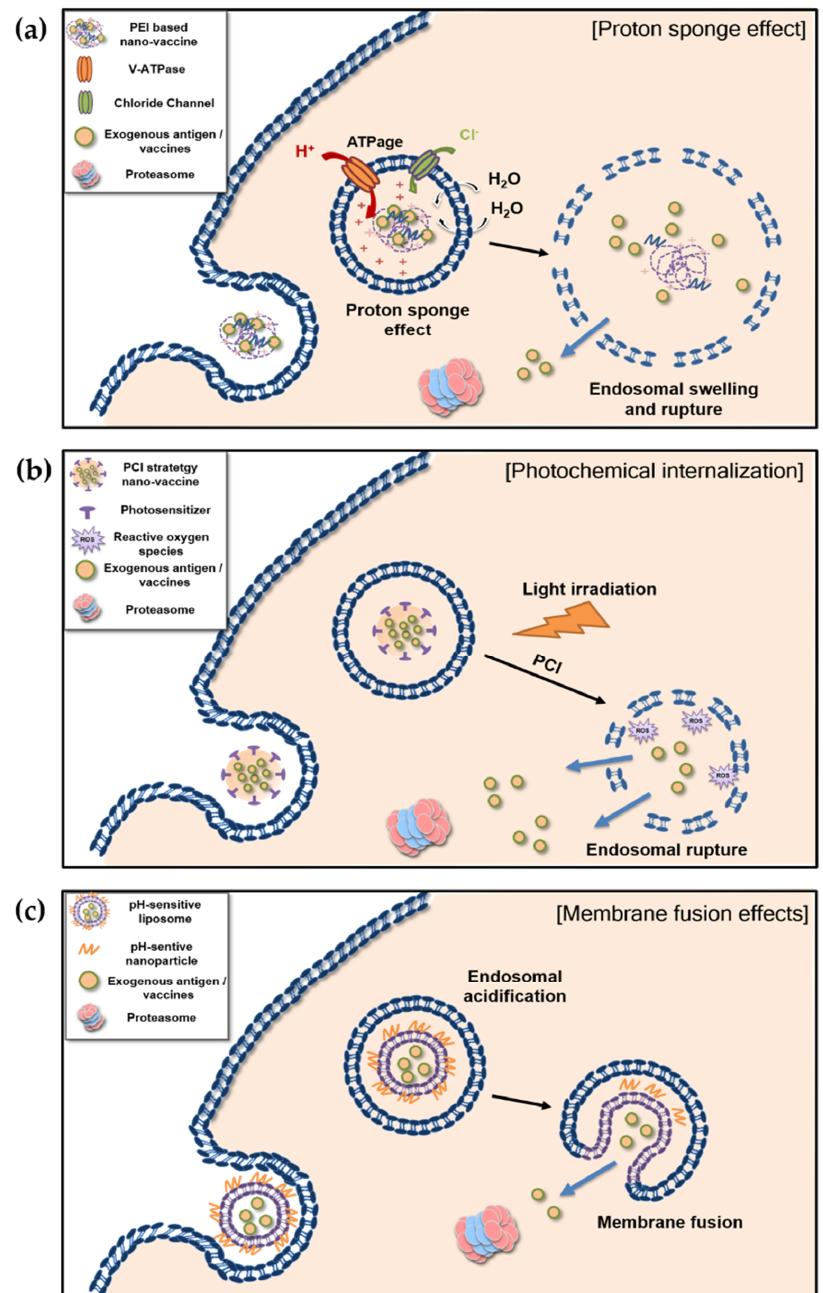
Figure 2. Schematic representation of the mechanism of a nanovaccine inducing cytosolic exportation, leading to cross-presentation: ( a ) proton sponge e ff ect, ( b ) photochemical internalization, ( c ) membrane fusion e ff ect of pH-sensitive liposome. ( a ) After cationic PEI-based nanovaccines are taken up, and an unsaturated amino group bu ff ers the influxing proton, supplied by a proton pump, v-ATPase. The proton pump continuously transports the protons into endosomes, which results in retention of chloride ions and water. Eventually, osmotic swelling and rupture of endosomes expose the antigen and vaccine compartment to the cytosol; ( b ) Photochemical internalization based nanovaccines contain a photosensitizer responding to a specific wavelength of light. After light irradiation, the photosensitizer initiates of reactive oxygen species, leading to rupturing of endosomes and cytosolic exports; ( c ) After endocytosis of liposomes combine with pH-sensitive nanoparticles, early endosome become acidic along with endosomal maturation. The acidic condition destabilizes the pH-sensitive liposomes, leading to enhanced membrane fusion with export of antigens into